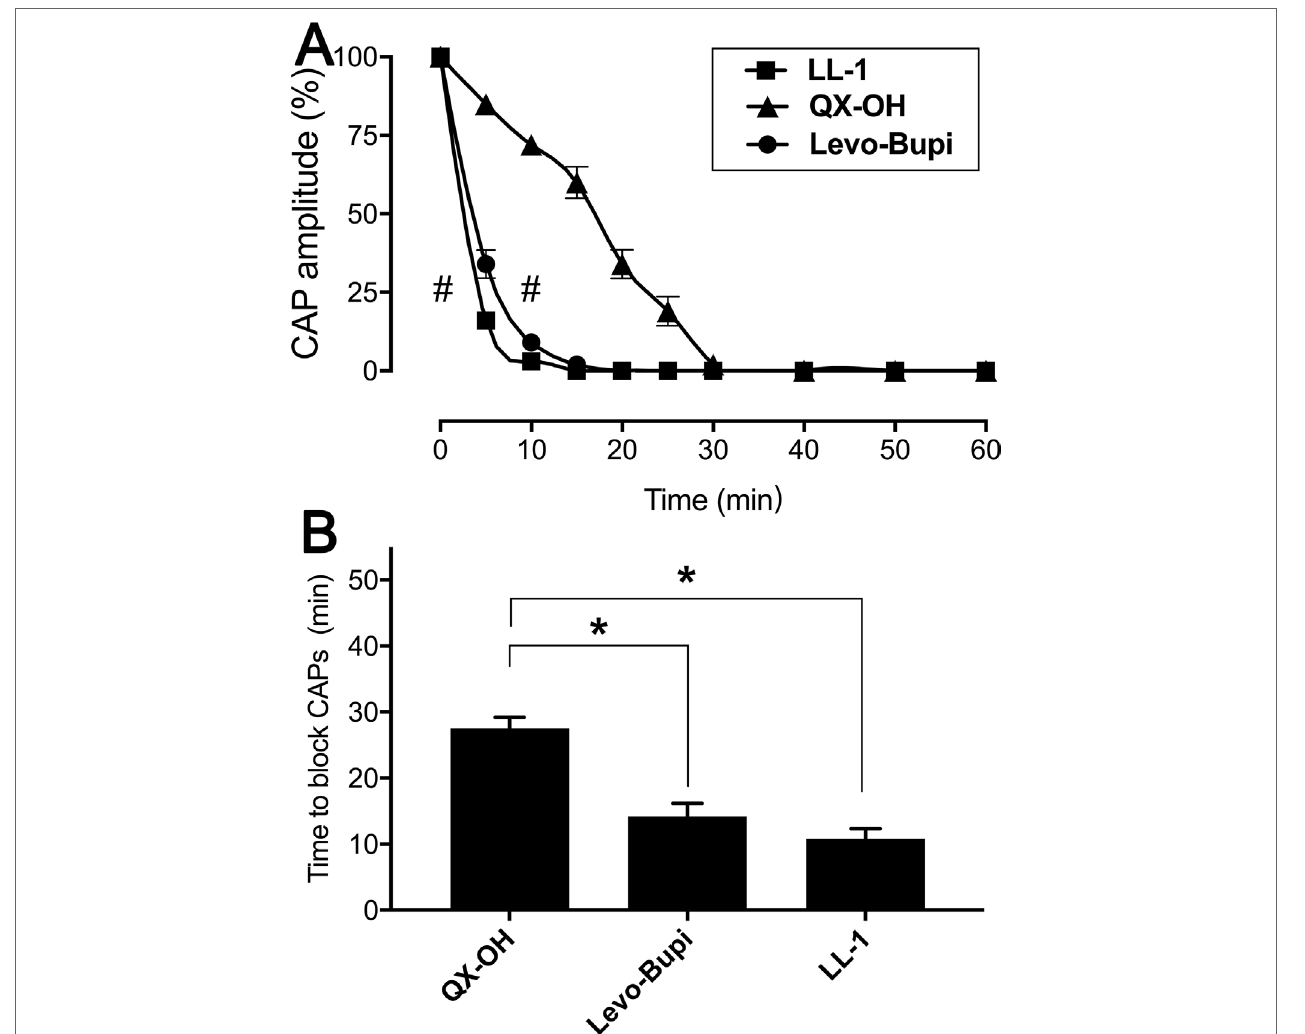
FIGURE 3 | Effects of LL-1, QX-OH and Levobupivacaine on frog sciatic nerve CAPs. (A) the CAP amplitude; (B) The time to block CAPs, n = 6 in each group). Data are expressed as mean ± SEM. * p < 0.05, # p < 0.001. Levo-Bupi, levobupivacaine, LL-1: 35 mM QX-OH/10 mM